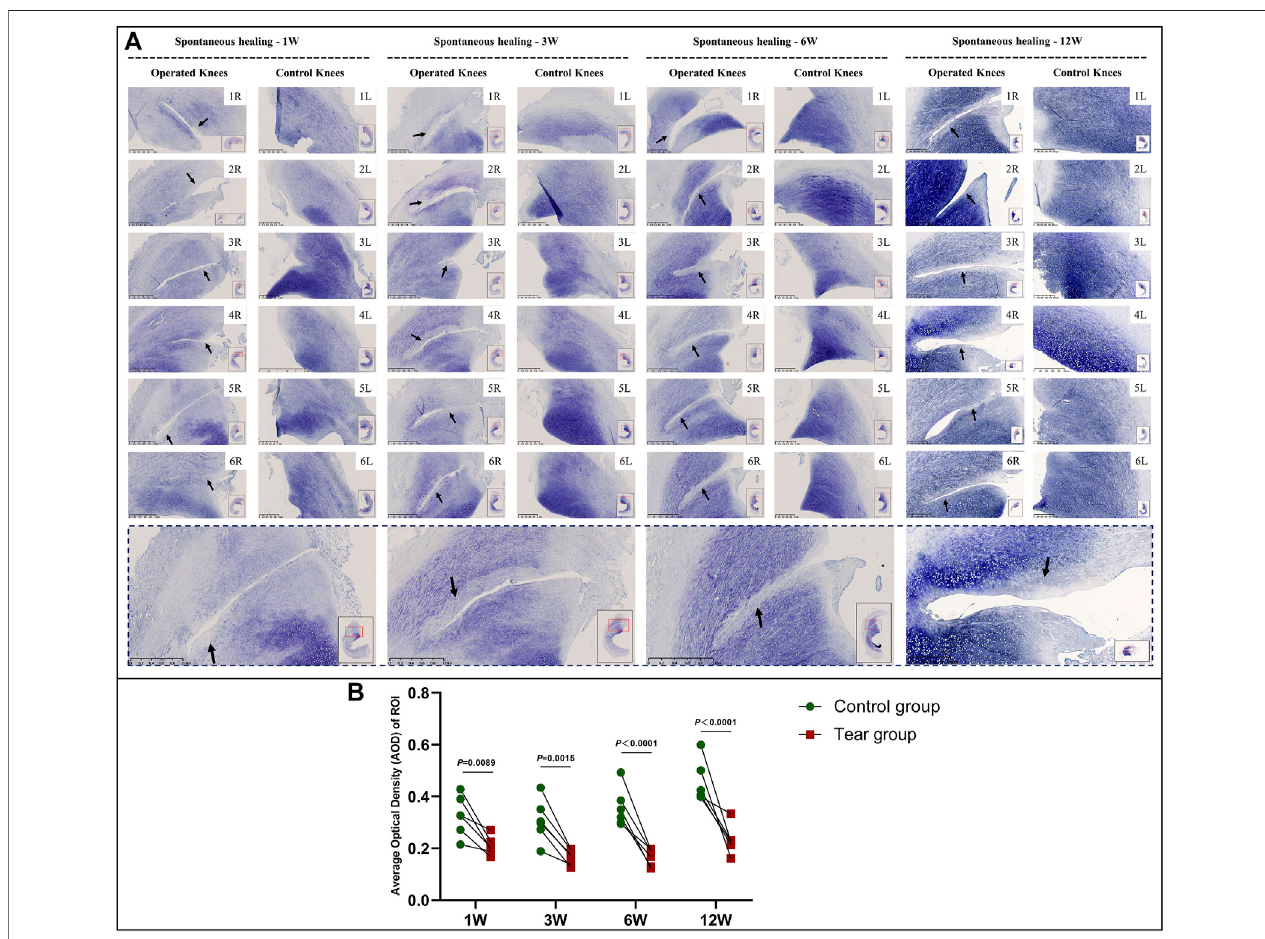
FIGURE7| ToluidinebluestainingandsemiquantitativeevaluationofGAGcontentinmaturemenisci. (A) Toluidinebluestaining. (B) Semiquantitativeevaluationof GAGcontent.Theblackarrowsindicatethefadingoftoluidineblue stain.Thelowerpanelofimages withablack dotted-line border indicate representativespecimensin the corresponding observation period. AOD values are expressed as median values with 95% CIs. n (cid:1) 6.